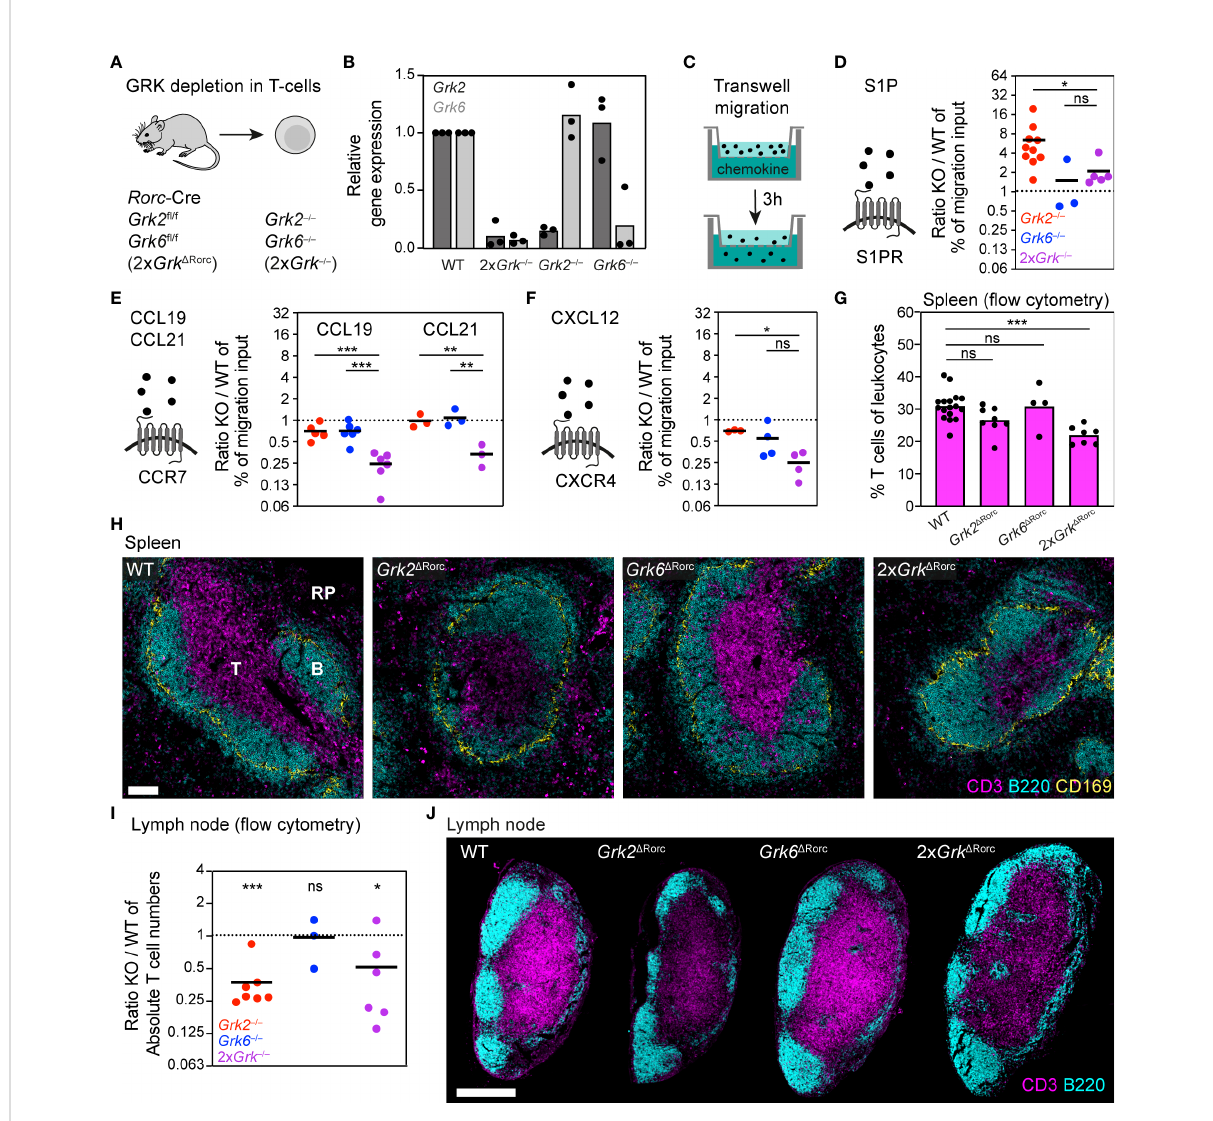
FIGURE 2 T cells lacking GRK2 and GRK6 show distinct effects on S1PR-, CCR7- and CXCR4- controlled migration (A) Scheme of the mouse model used for the generation of T cells with individual and combinatorial GRK depletion. (B) Con fi rmation of GRK knockout ef fi ciency by quantitative RT-PCR. Relative gene expression of splenic Grk -de fi cient T cells, normalized to WT T cells. n = 3 biological replicates performed as independent experiments with N =3 technical replicates each. Bars display the mean. (C) Scheme of the transwell migration assay, in which cells migrate over 3 h from an upper compartment into an attractant- fi lled lower well. (D – F) Schemes of chemoattractants and their corresponding GPCRs. Transwell migration of splenic T cells toward 100 nM S1P (D) , 1 µg/ml CCL19 and 1 µg/ml CCL21 (E) and 0.5 µg/ml CXCL12 (F) . Displayed are ratios of Grk -knockout (KO) versus WT. n = 3-8 biological replicates performed as independent experiments with N = 2 technical replicates each. Bars display the mean. *** P < 0.001, ** P < 0.01, * P < 0.05, ns nonsigni fi cant, post hoc after or ANOVA. (G) Frequency of T cells in spleens compared to all leukocytes, measured by fl ow cytometry. n = 4-8 mice per gene knockout. Bars display the mean. ** P <0.01, ns nonsigni fi cant, post hoc after ANOVA. (H) Positioning of WT and Grk - de fi cient T cells in homeostatic spleens. Red pulp (RP), B cell follicles (B) and T cell zone (T) are indicated. T cells were detected with immunostaining against CD3 (magenta). B cells (B220, cyan) and marginal zone macrophages (CD169, yellow) are displayed for orientation. Scale bar: 100 µm. (I) Absolute numbers of T cells in inguinal lymph nodes measured by fl ow cytometry, displayed are ratios of KO vs. WT. n = 3-7 mice per KO. Bars display the mean. *** P < 0.001, * P <0.05, ns nonsigni fi cant, one sample t test. (J) Positioning of WT and Grk -de fi cient T cells in homeostatic lymph nodes. T cells were detected with immunostaining against CD3. B cells (B220) are displayed for orientation. Scale bar: 300